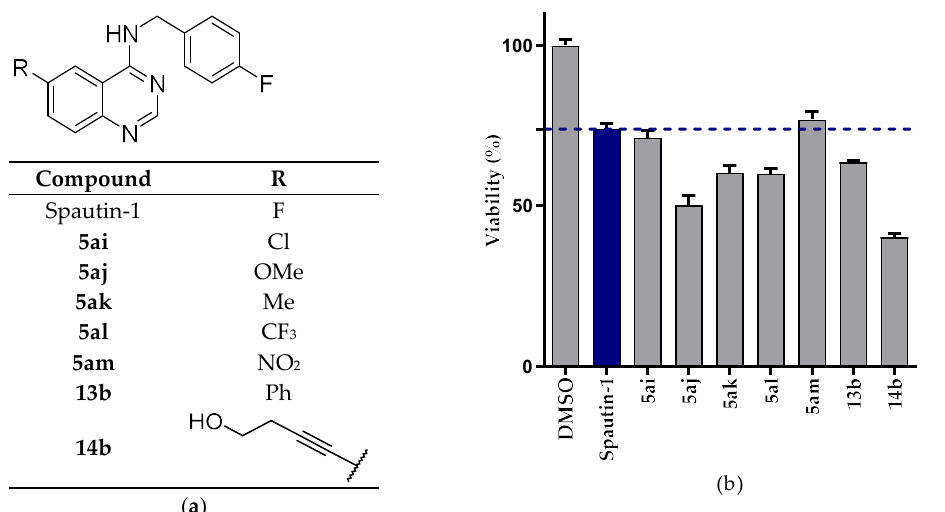
Figure 5. ( a ) Substituents at the 6-position of the quinazoline core were altered; ( b ) viability assay (5 µ M) with Spautin-1 as reference.